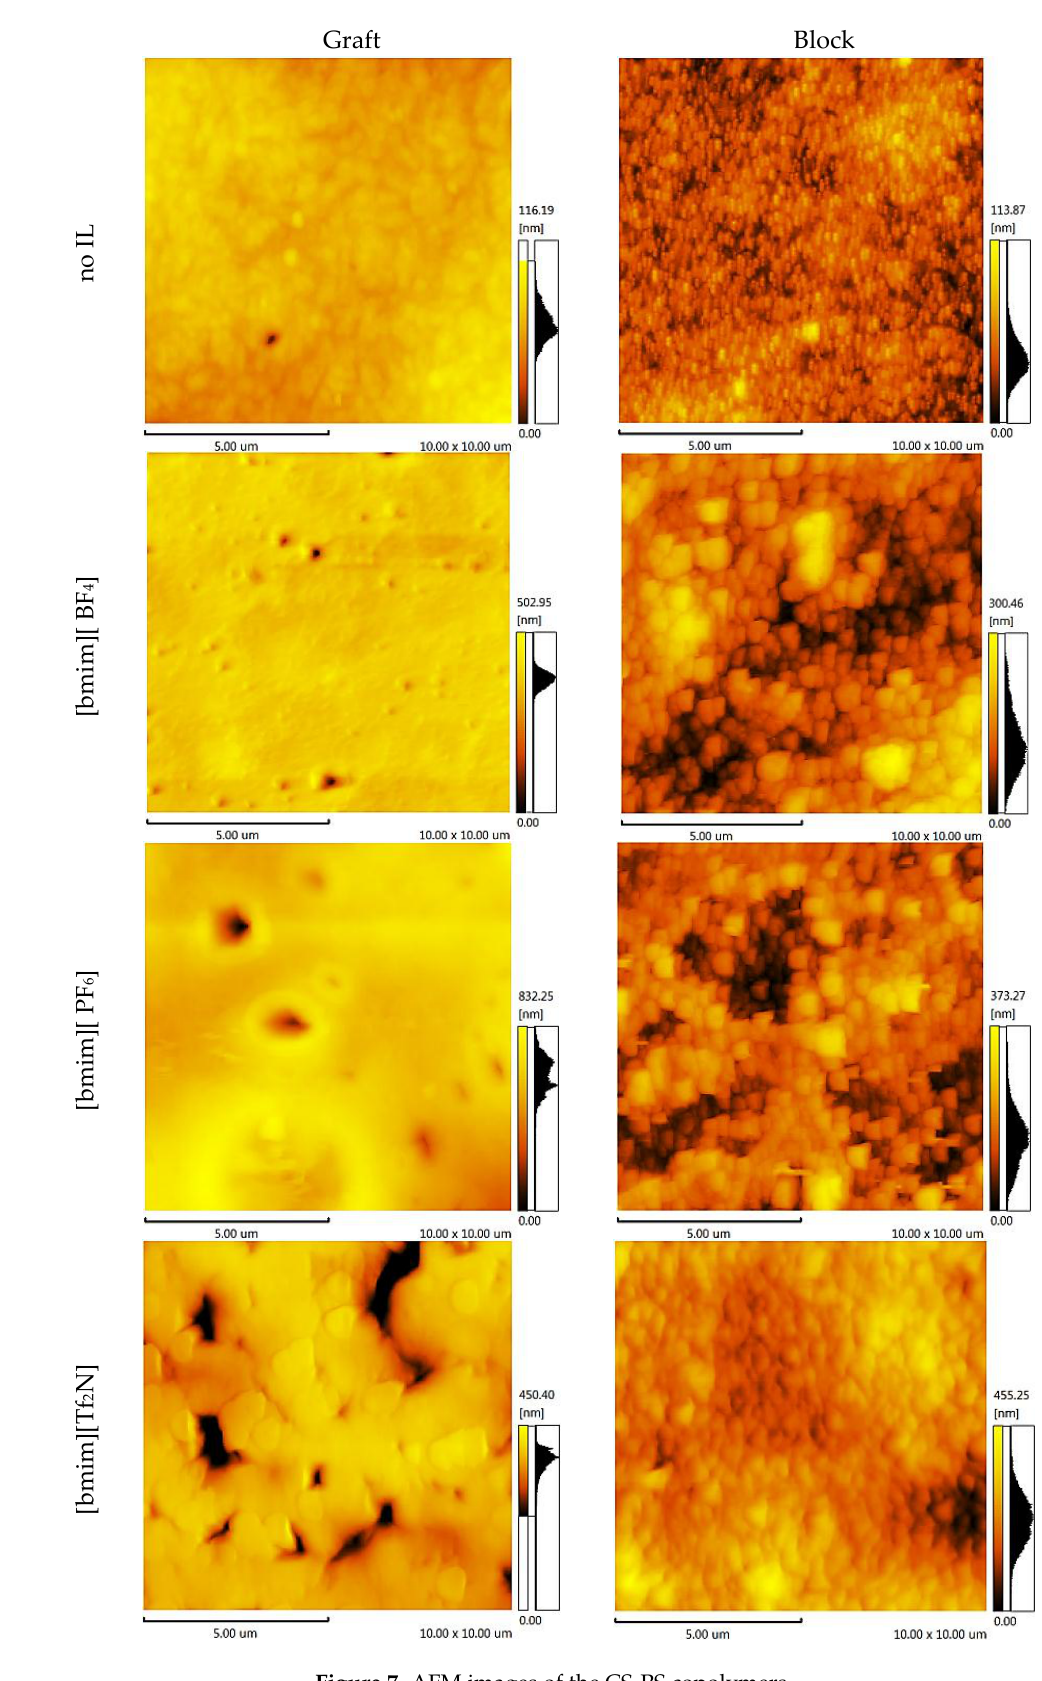
Figure 7. AFM images of the CS-PS copolymers.